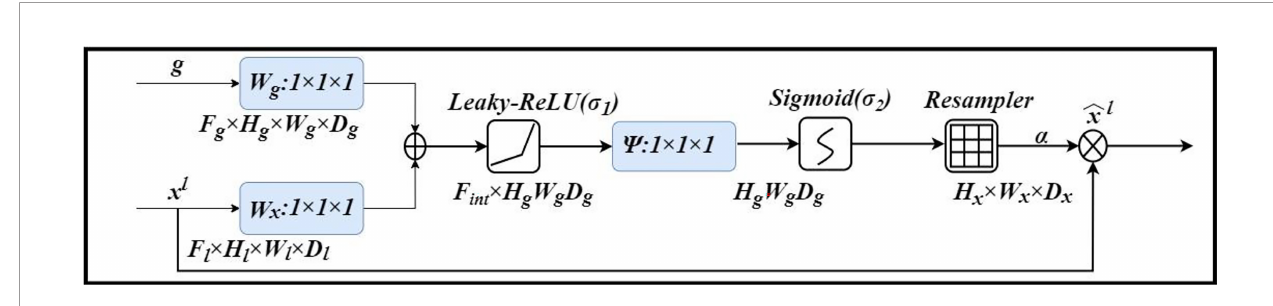
FIGURE 4 | Attention Gate